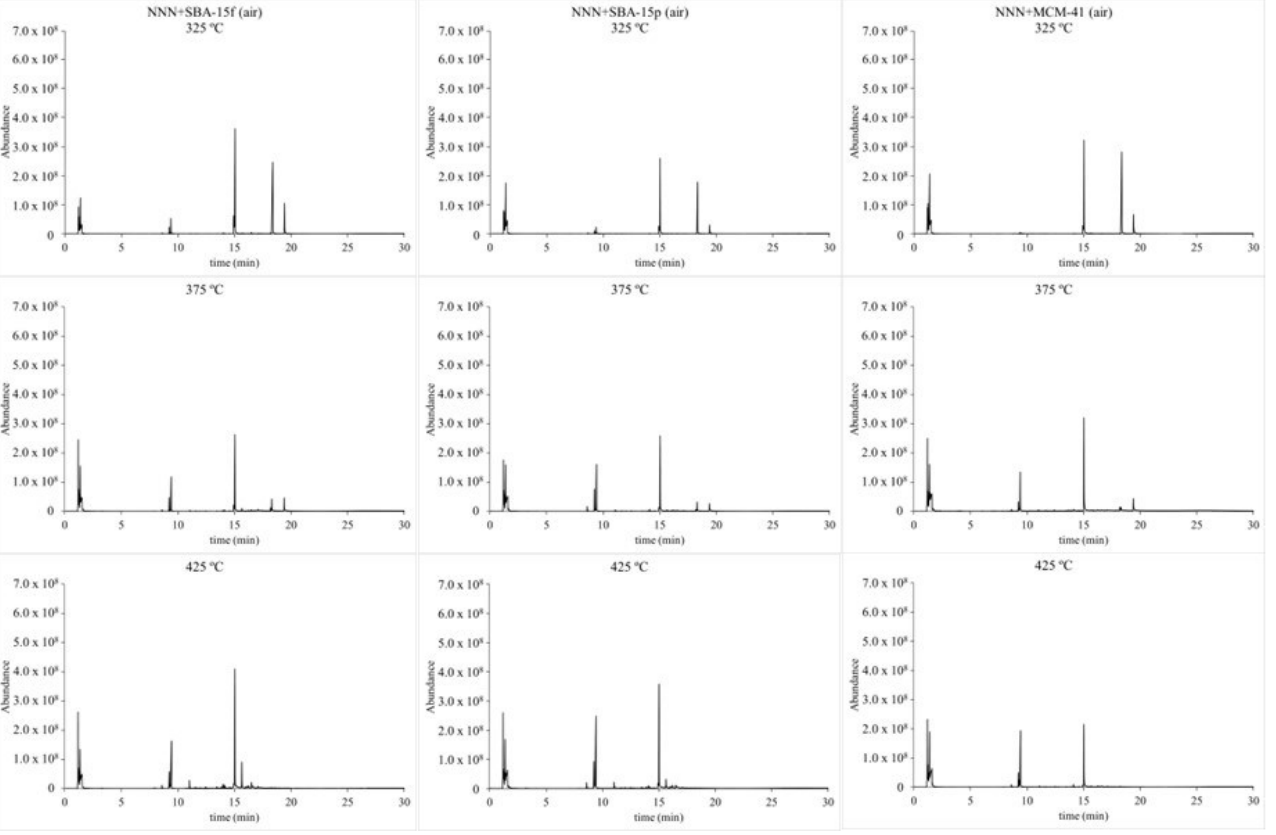
Figure 14. Chromatograms of the pyrolysis of NNN with SBA-15f (left), SBA-15p ( center ) and MCM-41 ( right ) at different temperatures, under the air atmosphere.